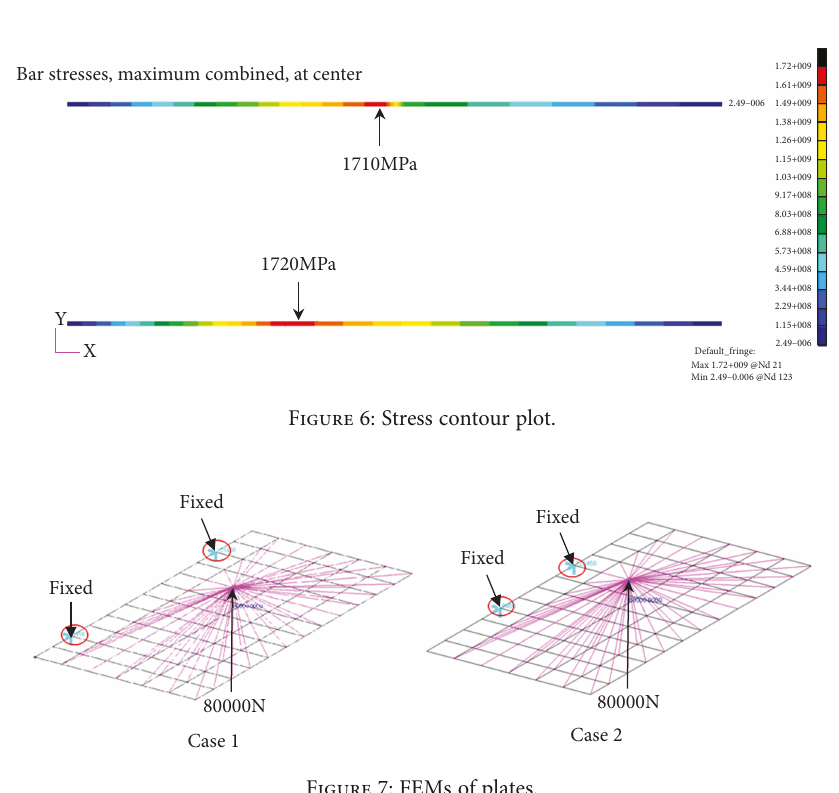
Figure 7: FEMs of